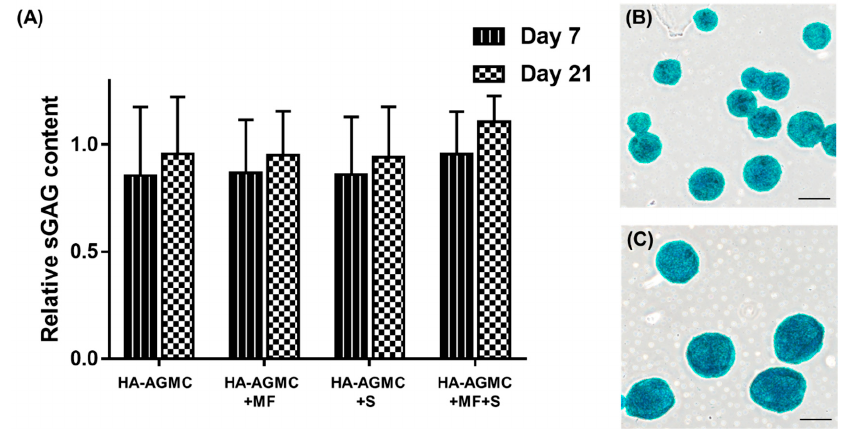
Figure 7. The cartilage tissue-mimetic pellets productivity of sGAG. ( A ) Blyscan assay detected sGAG content in culture medium under different stimulations at 7 and 21 day (n = 3). Alcian blue staining demonstrated the secretion of sGAG after 21 days culture of ( B ) control and ( C ) HA-AGMCs. scale bars = 200 μ m.